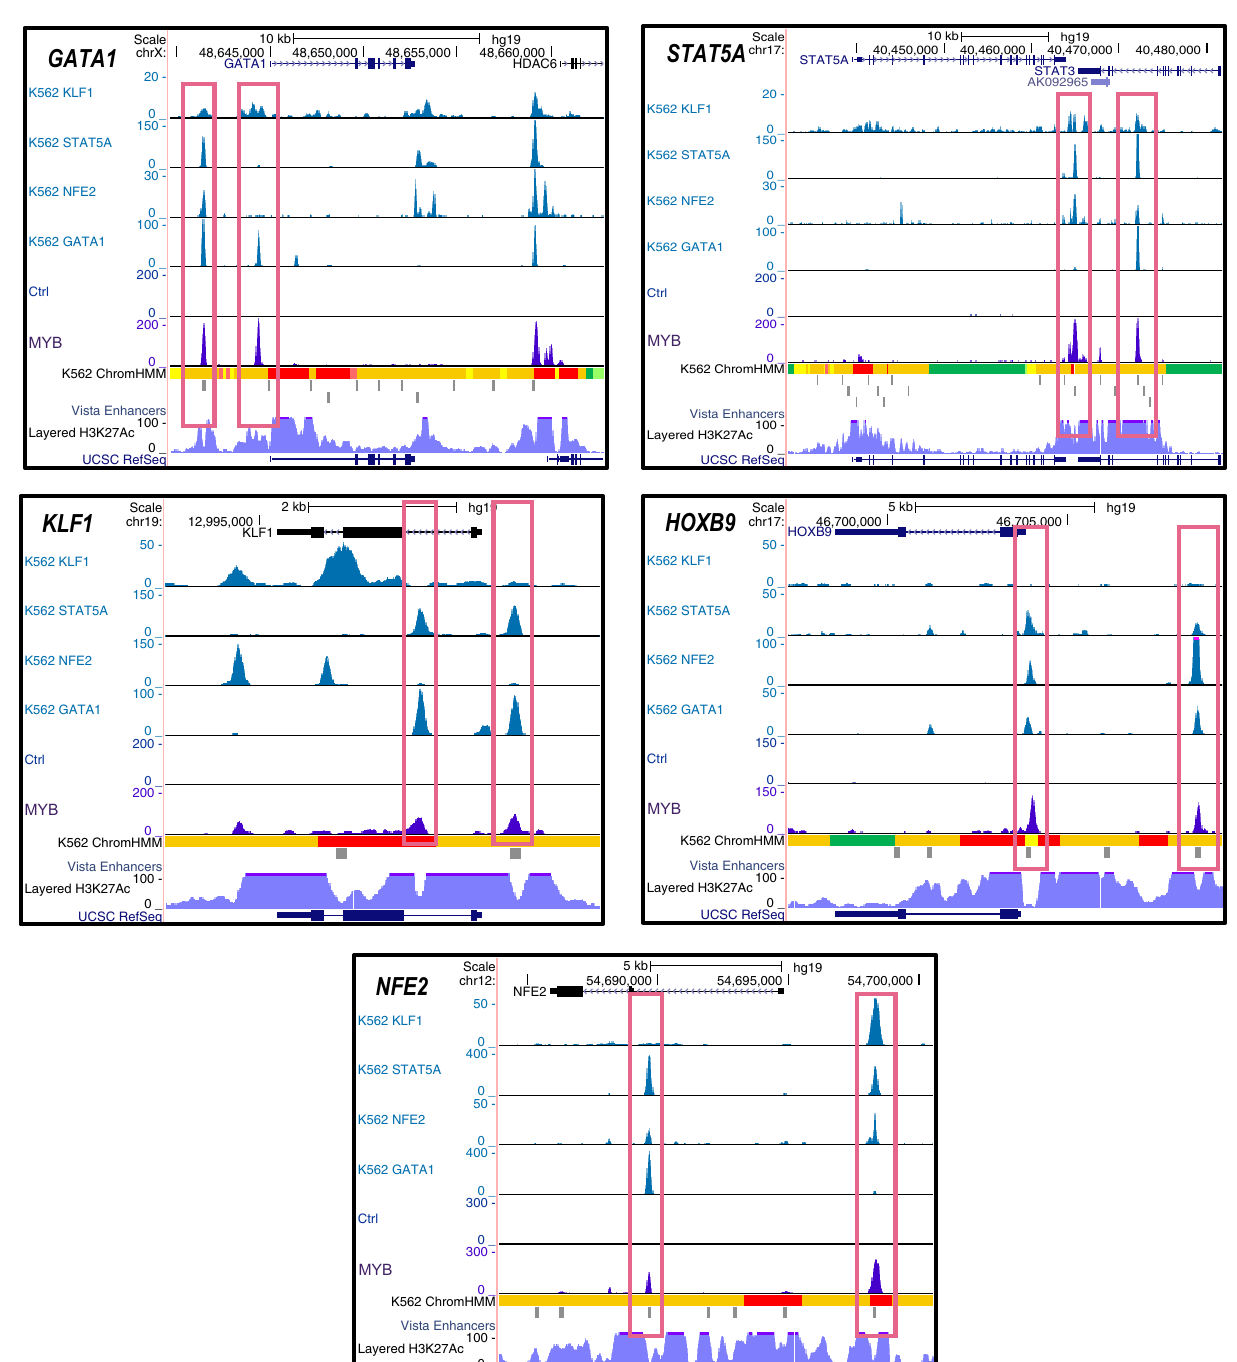
Figure 8. MYB has a master regulatory property. MYB occupies the promoter and enhancer regions of key regulators of gene programs in K562: GATA1 , STAT5A , KLF1 , HOXB9 , and NFE2 loci. Publicly available K562 ChIP-seq data for GATA1, NFE2, STAT5A and KLF1 are displayed along with the current MYB ChIP-seq data and K562 chromHMM chromatin segmentation tracks, the latter used to define enhancer regions. Visualization of the tracks were made using the UCSC genome browser 76 (https:// genome. ucsc. edu/) by creating a UCSC session containing the K562 control and MYB ChIP-seq bigwig files from the current study along with the bigwig files of publicly available K562 ChIP-seq data for KLF1 (ENCFF153SCC), STAT5A (ENCFF746KSV), NFE2 (ENCFF399JNI), and GATA1